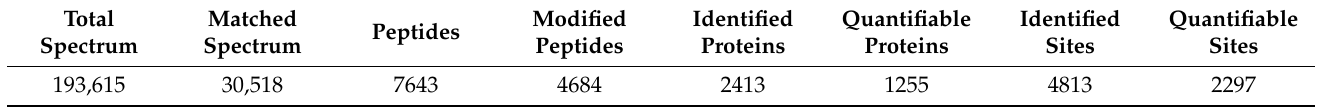
Table 1. Summary of mass spectrum data results.